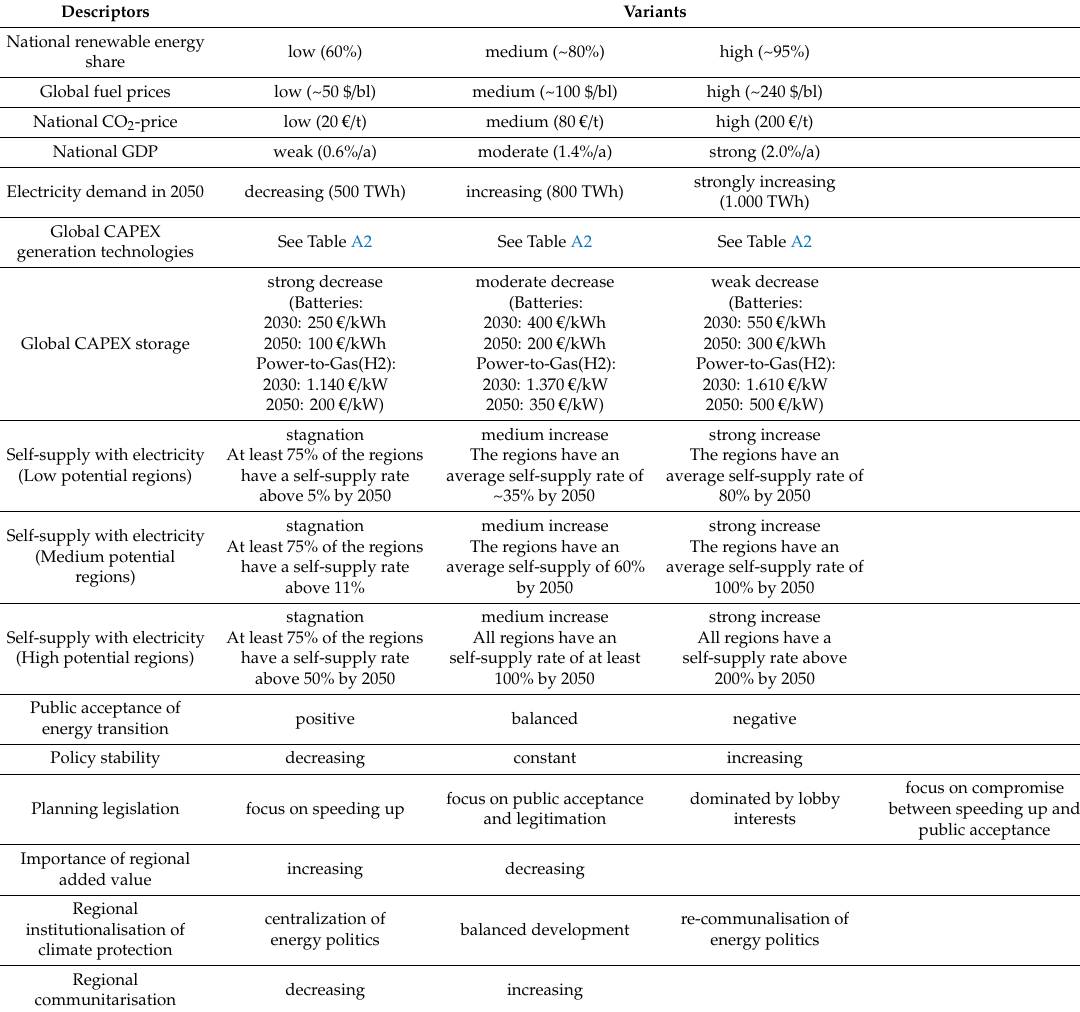
Table A1. Overview of descriptors and variants.